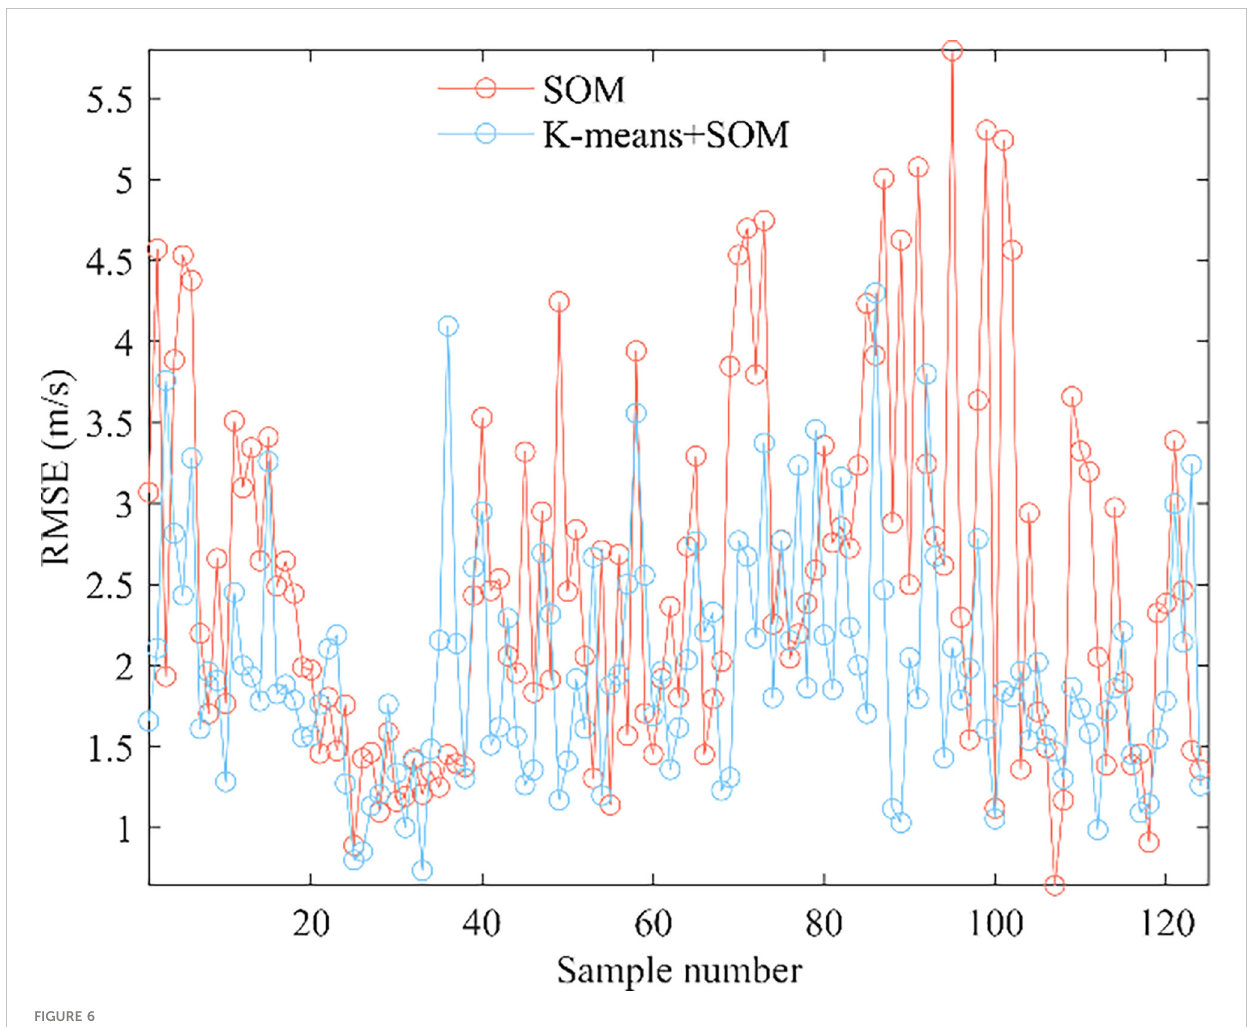
FIGURE 6 Error per sample for the test